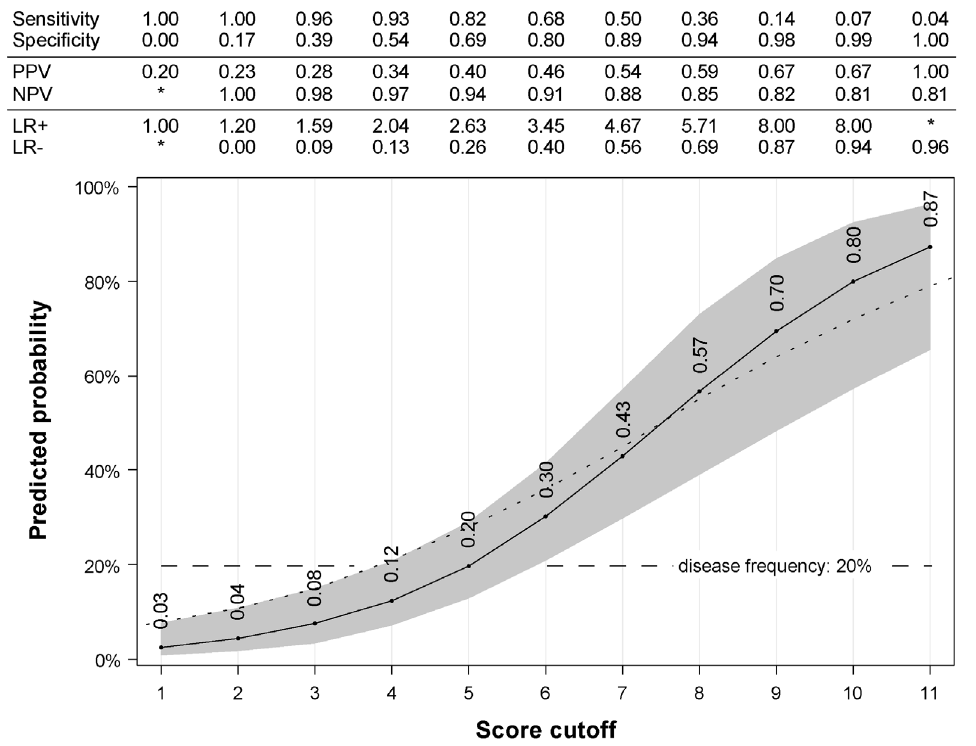
Fig. 2. Predicted probability of developing asthma 5 years later, for a single particular score value. Performance measures by score in table above. Primary inclusion, scoring, and outcome definitions. Probabilities from original paper (dotted line). * Values not meaningful and/or no accurate estimate possible. PPV/NPV, positive/negative predictive value; LR + /-, positive/negative likelihood ratio.